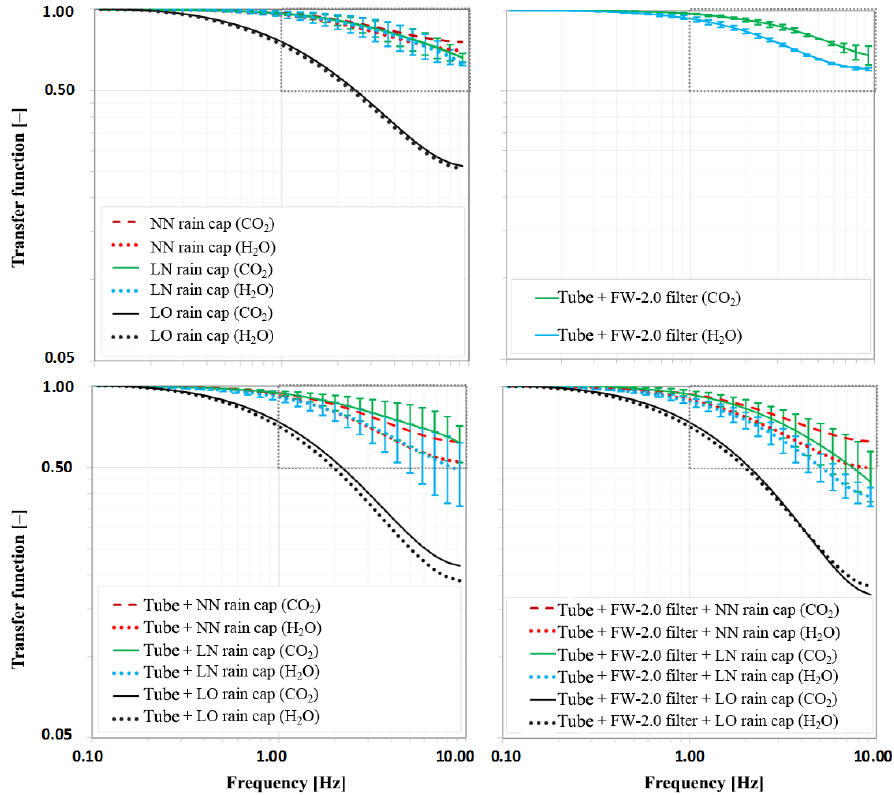
Figure 3. Transfer functions of different gas sampling system components and combinations thereof, without heating or insulation, as de- termined by laboratory tests. Dotted grey boxes indicate approximate desirable ranges for a short-tube low-power implementation, requiring minimal corrections. Bars indicate range from multiple experiments, where available, as described in Sect. 2.1. Please note that the y axis starts at 0.05. Top left panel: three selected rain caps NEON new (NN), LI-COR new (LN) and LI-COR old (LO), without tube and filter. Top right panel: tube and Swagelok FW-2.0 filter (Table 2 provides detailed specifications), without rain cap. Bottom left panel: tube and three selected rain caps, without filter. Bottom right panel: tube, FW-2.0 filter and three selected rain caps.